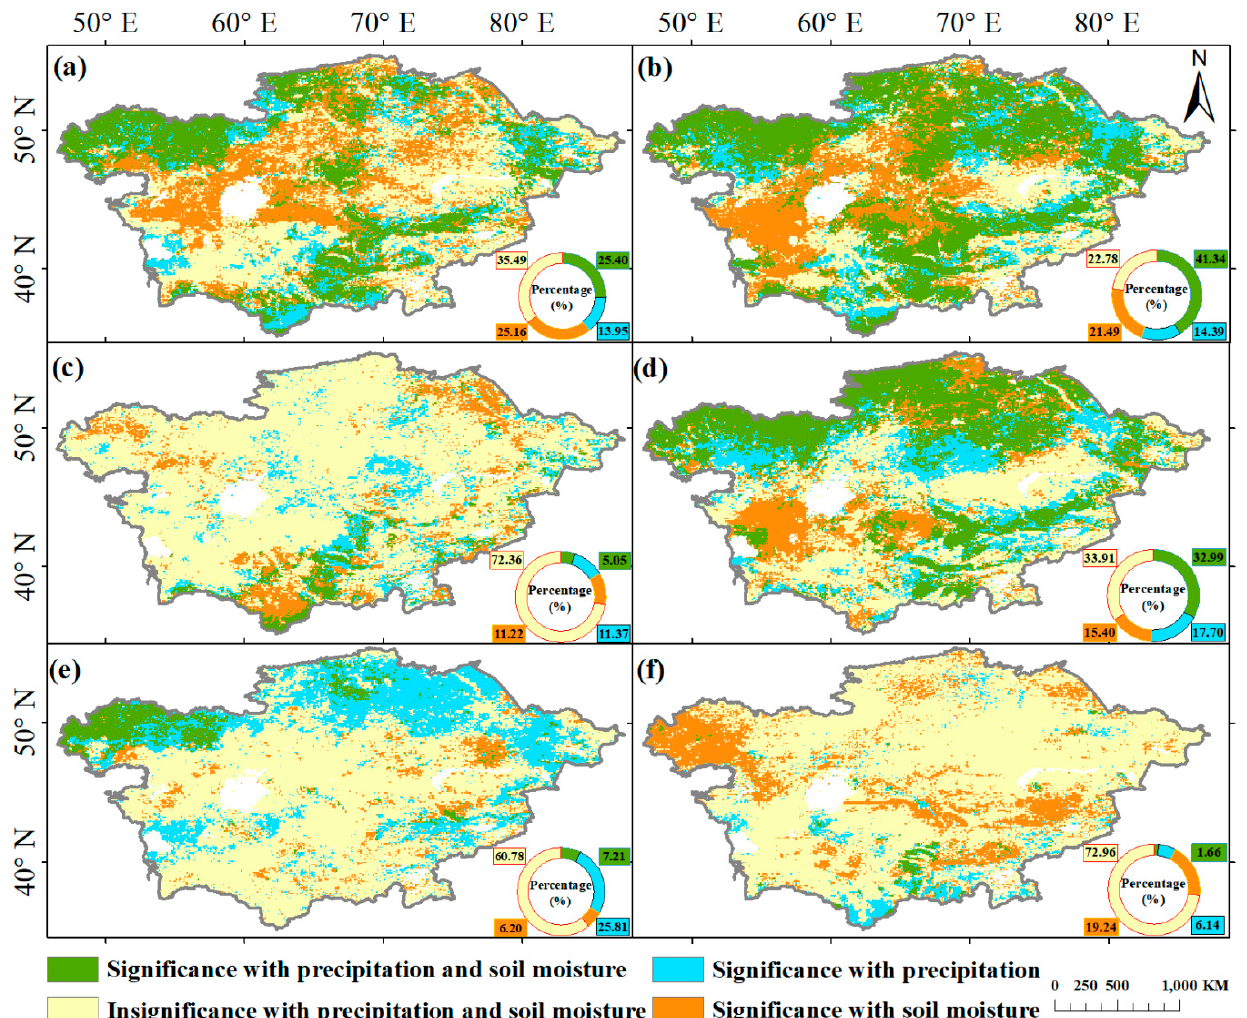
Figure 4. Spatial distribution of significant correlations between the annual ( a ) and growing season ( b ) scales, and the spring ( c ), summer ( d ), autumn ( e ), and winter ( f ) NDVIs and water conditions in Central Asia during the period 1982 to 2015.